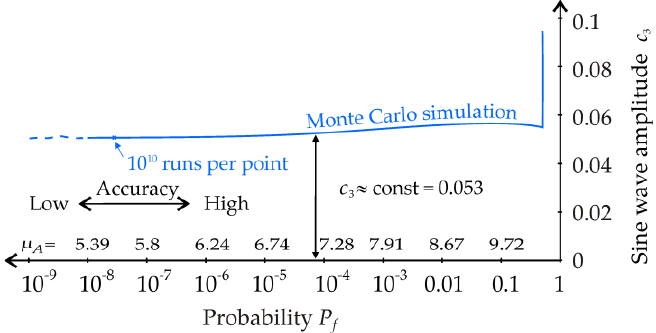
Figure 12. Parameter of pseudorandom model uncertainty — case study 6.